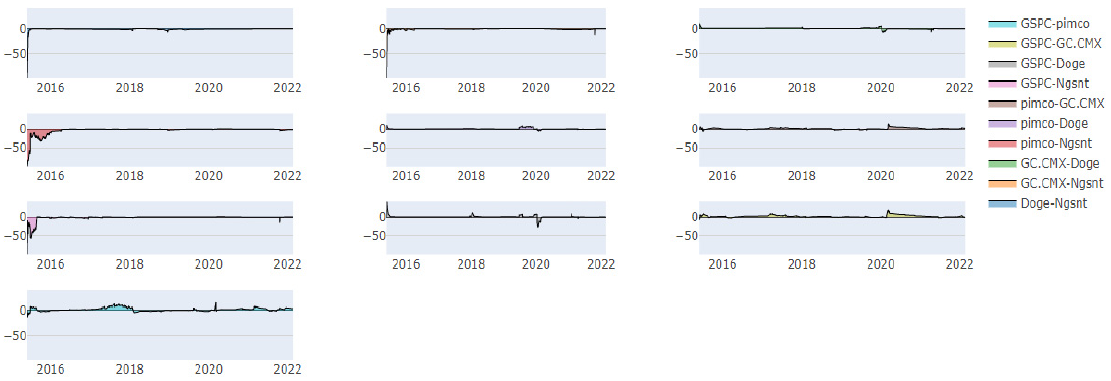
Figure 4. Net pairwise directional connectedness (NPDCI).